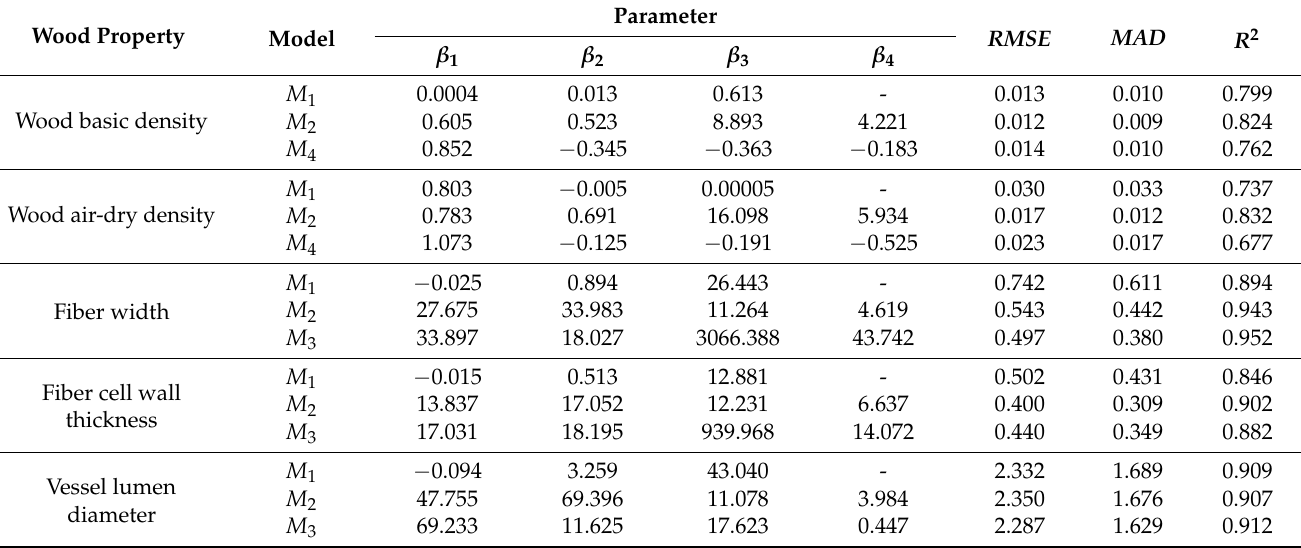
Table 5. Fitting parameters and evaluation of models of different wood